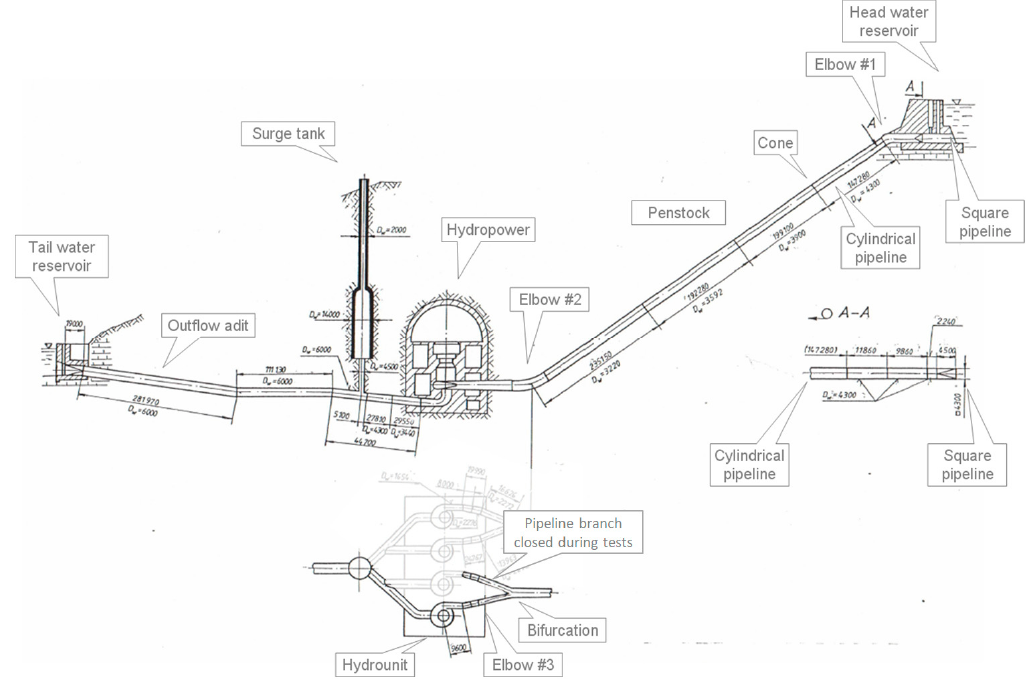
Figure 1. Flow system of the pump-turbine.